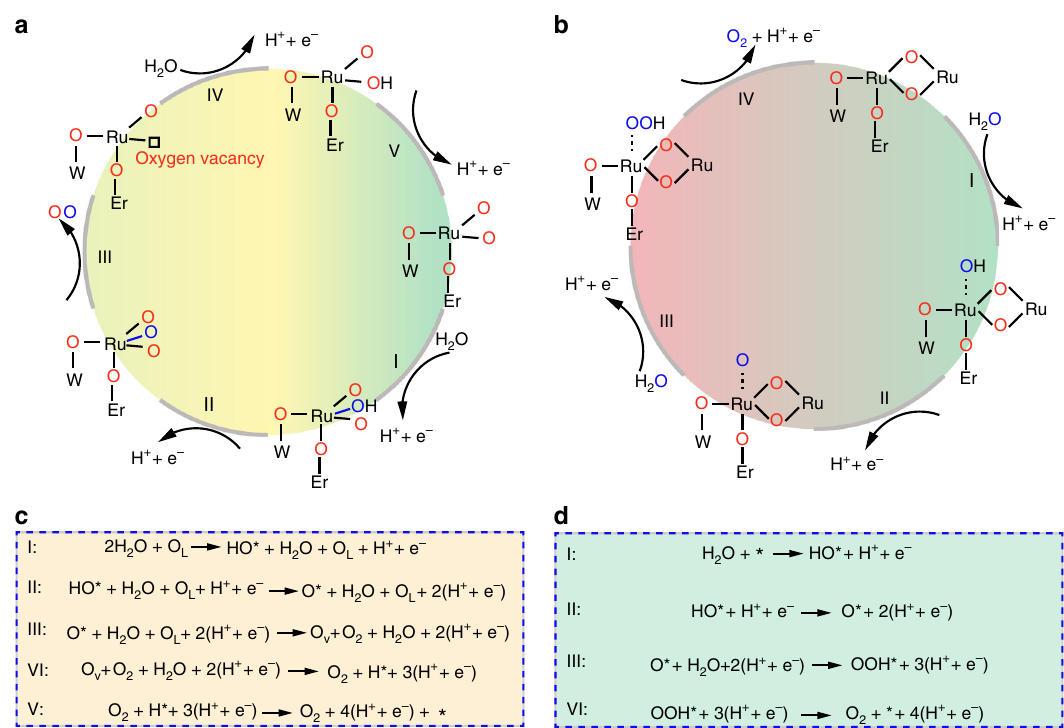
Fig. 1 Schematic illustration of W 0.2 Er 0.1 Ru 0.7 O 2 − δ toward acidic OER. a The illustration of lattice oxygen oxidation way of W 0.2 Er 0.1 Ru 0.7 O 2 − δ toward acidic OER. b The illustration of adsorbate evolution way of W 0.2 Er 0.1 Ru 0.7 O 2 − δ toward acidic OER. c the reaction paths of W 0.2 Er 0.1 Ru 0.7 O 2 − δ for lattice oxygen oxidation. d the reaction paths of W 0.2 Er 0.1 Ru 0.7 O 2 − δ for adsorbate evolution oxidation (* represents the surface-bound species on W 0.2 Er 0.1 Ru 0.7 O 2 − δ